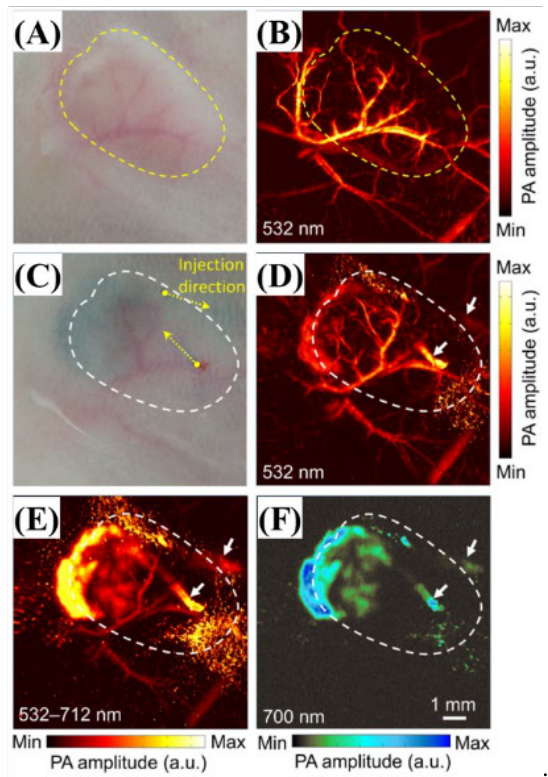
Figure 10. ( A , B ) Photograph and corresponding PA MAP image of blood vessels in the mouse tumor model ( C – F ). The wavelength and the corresponding pulse energy were as follows; ( B , D ) 532 nm, 0.8 μJ; ( E ) 532–712 nm (full spectrum), 1.5 μJ; ( F ) 700 ± 12.5 nm, 0.2 μJ. Reprinted from Bui et al., Sci. Rep., 2016, 8,1:018-20139-0 [26], with permission of Spring Nature.